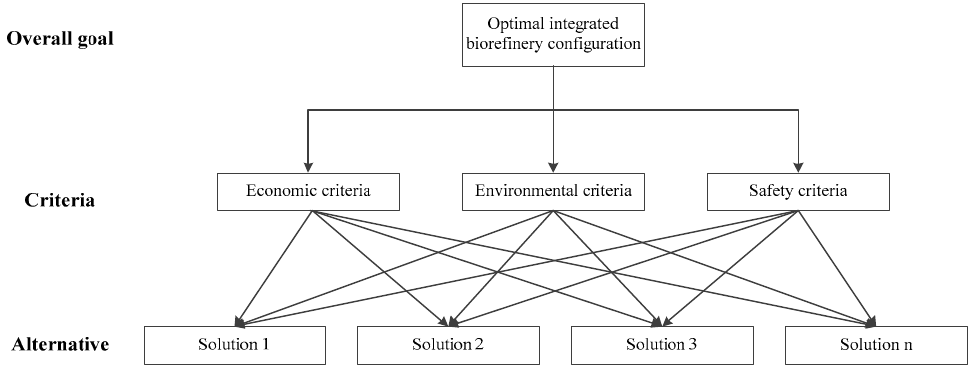
Figure 4. Schematic of alternate Pareto-optimal solutions for the integrated biorefinery.